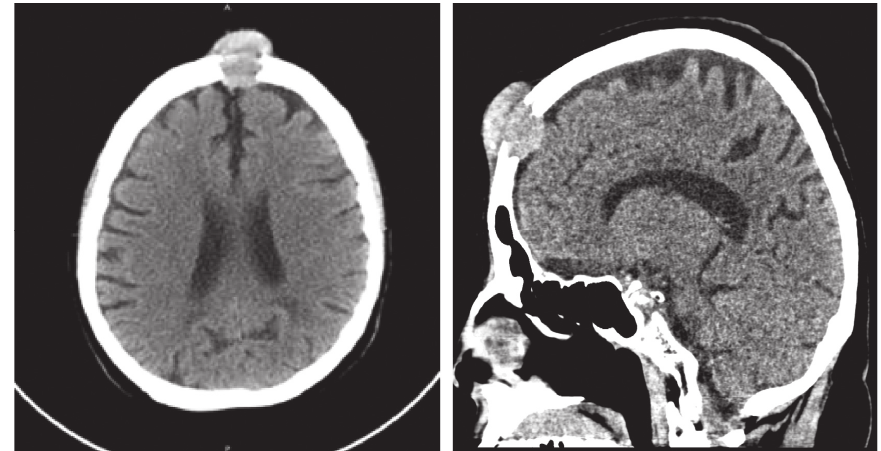
Figure 2: Cross-sectional and sagittal images of CT head (with and without contrast) demonstrating a 3.1 cm × 3cm × 3cm enhancing soft tissue mass eroding through the frontal calvarium and extending into the anterior soft tissues of the scalp in the epidural space overlying the left frontal lobe.